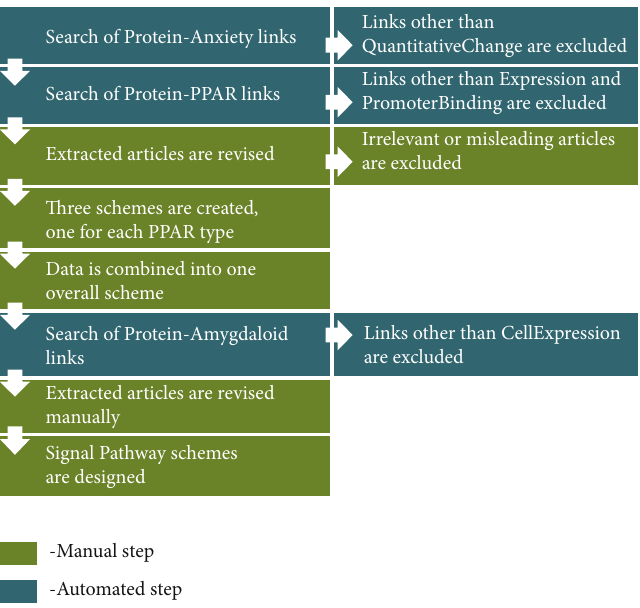
Figure 1: Work fl ow used in our study. Description in the